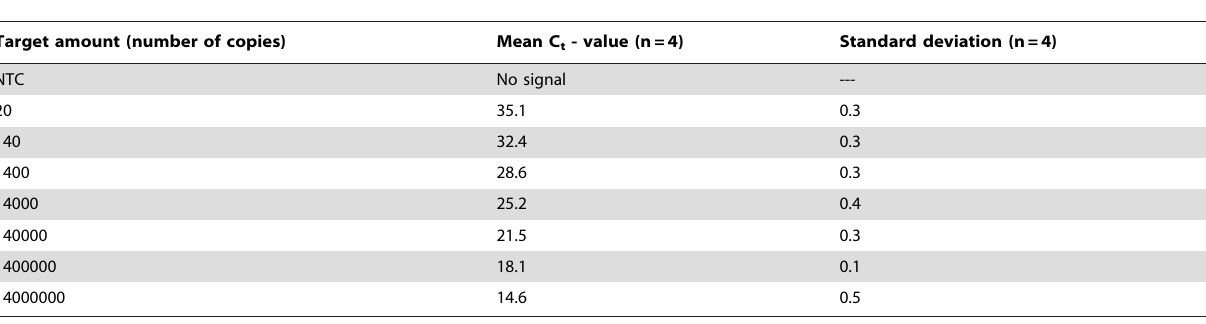
The table show the initial target amount, the mean C t - value and the standard deviation for the linearity experiments. The number of replicates is indicated in the brackets. No C t - value was found for the NTC (no template